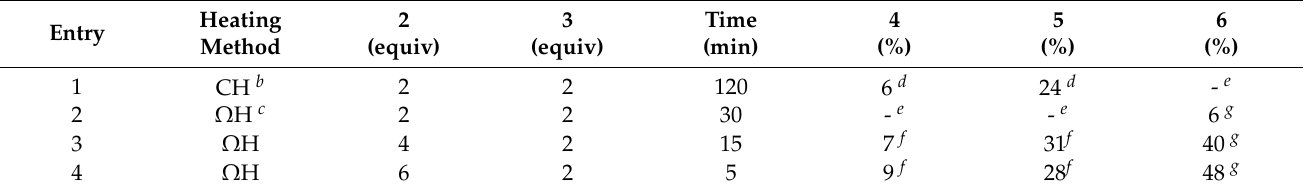
Table 1. Reaction conditions and yields for the Hantzsch reaction of 3-formylchromone 1 with methyl acetoacetate 2 and ammonium acetate 3 . a